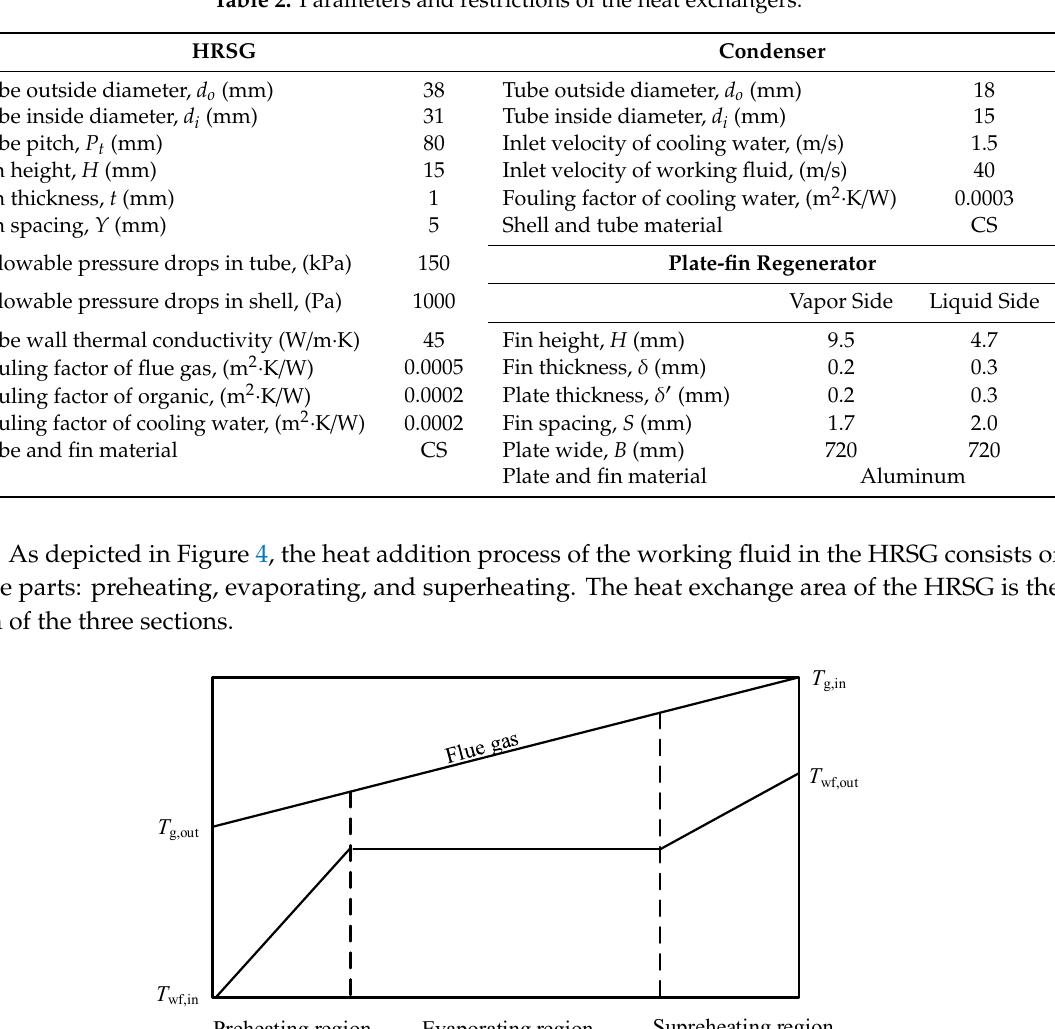
Table 2. Parameters and restrictions of the heat exchangers.